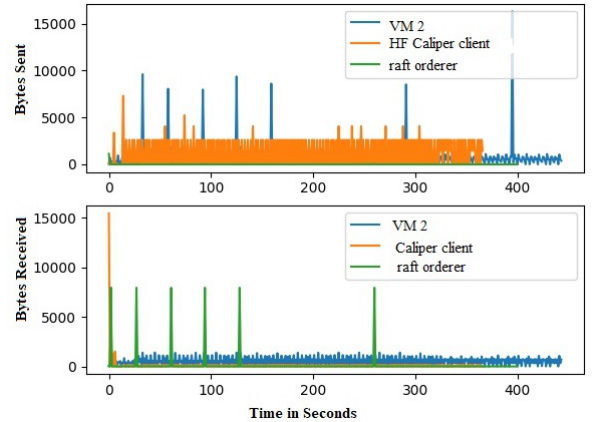
Figure 13. Transaction Traffic for VM 2.